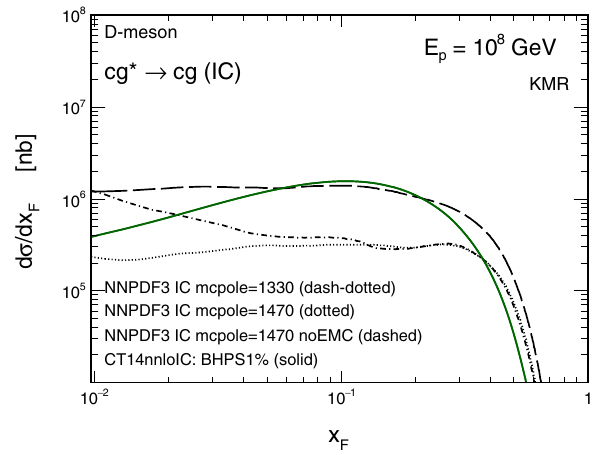
Fig. 11 Feynman x F distribution at E p = 10 8 GeV for different sets of the NNPDF3 parametrizations [46]. For comparison we show